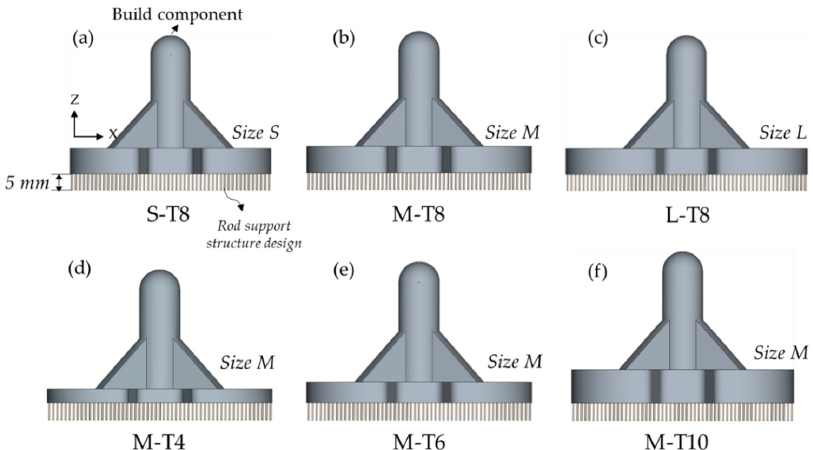
Figure 3. The model of each tibial component on the rod support structure with different tray sizes and tray thicknesses. ( a ) Small size with 8 mm thickness (S-T8); ( b ) Medium size with 8 mm thickness (M-T8); ( c ) Large size with 8 mm thickness (L-T8); ( d ) Medium size with 4 mm thickness (M-T4); ( e ) Medium size with 6 mm thickness (M-T6); ( f ) Medium size with 10 mm thickness (M-T10).